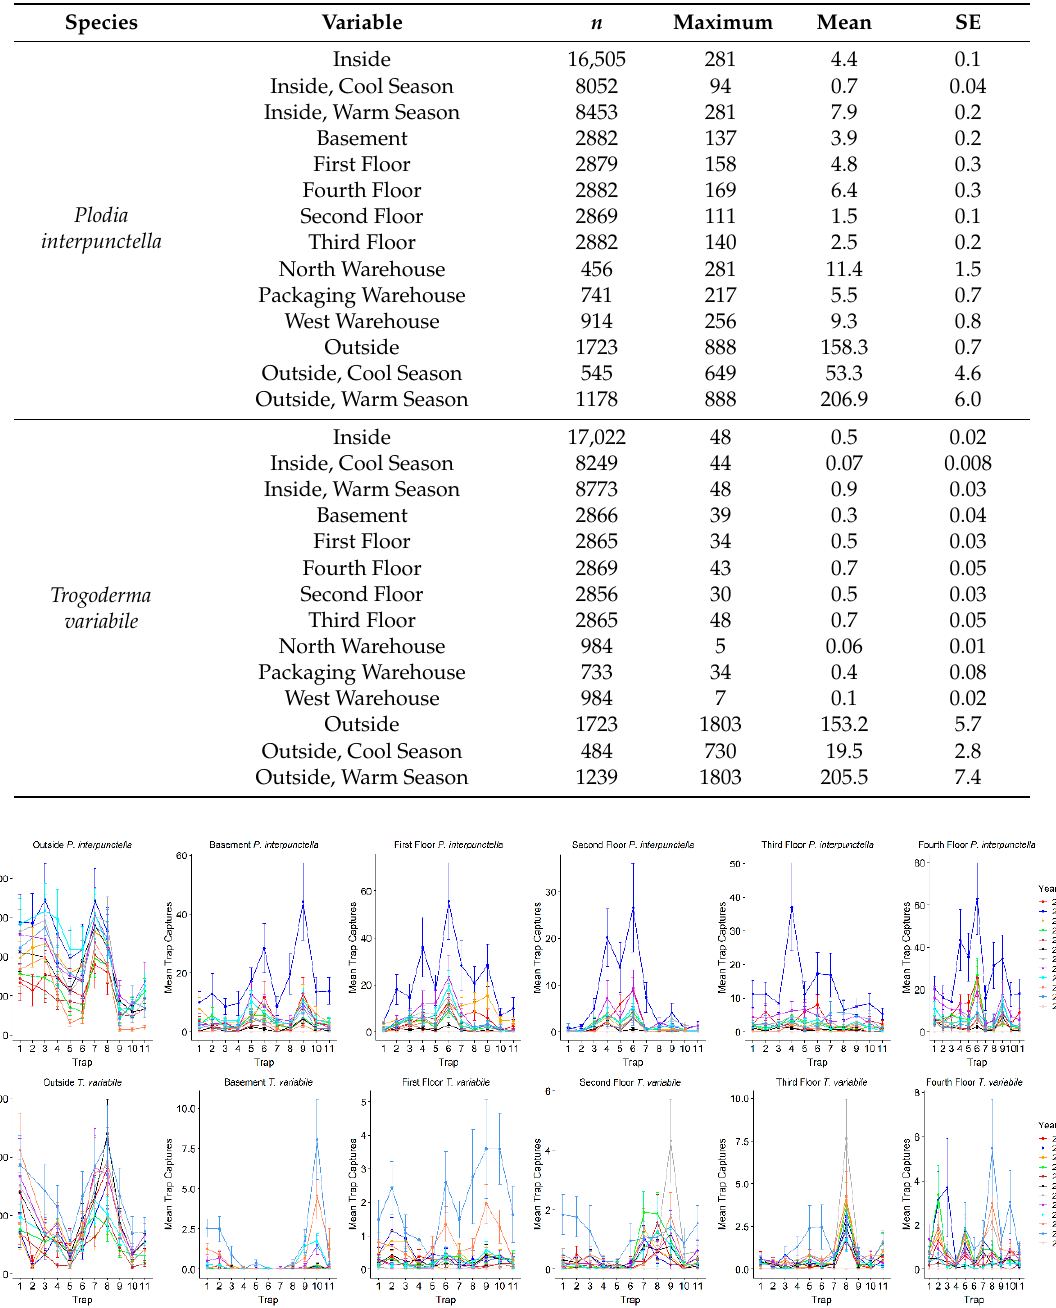
Figure 2. Line graphs of the mean insect captures for each species and location. Plodia interpunctella are in the top panels and T. variabile are in the bottom panels. Traps are on the x-axes and mean captures are on the y-axes; all y-axes have difference scales. Individual years are the different lines on each graph. Error bars are standard errors. Table 2. Counts with maximum and mean for overall inside/outside numbers, inside/outside during cool season and inside/outside during warm season. Minimum values were 0 for each location and season combination. SE = Standard Error.